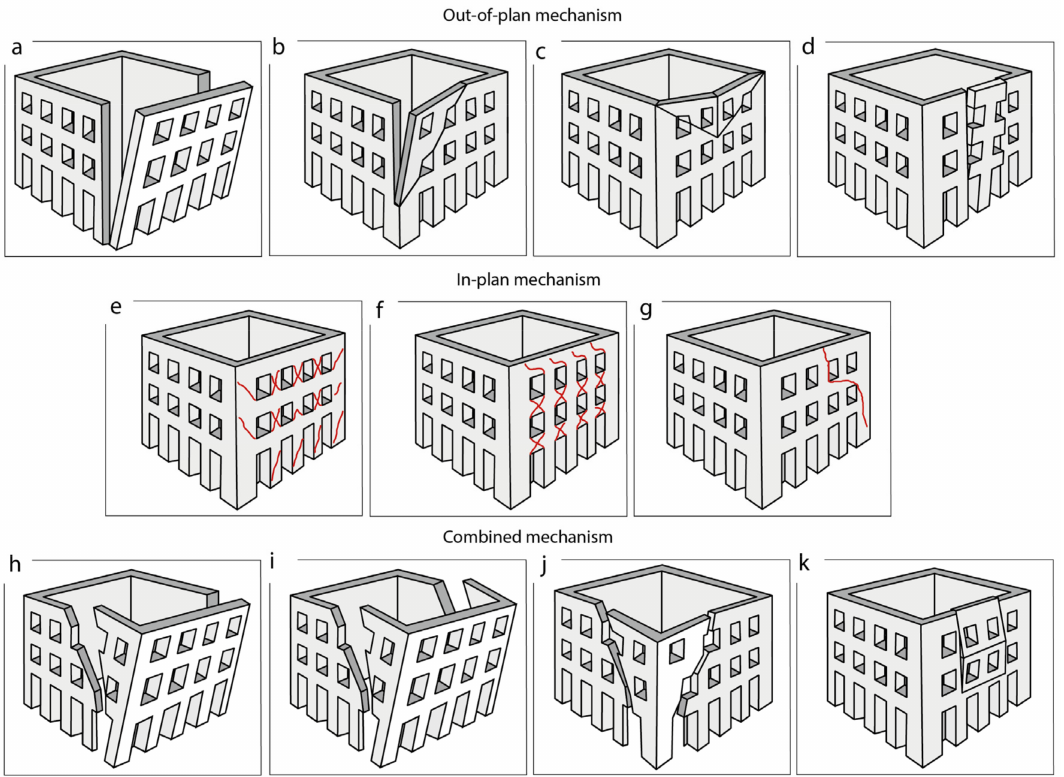
Figure 2. Schematic diagram of possible dissections in relation to a structure affected by a seis- mic event. Out-of-plane mechanisms: ( a ) total simple overturning of the wall; ( b ) partial simple overturning of the wall; ( c ) horizontal wall deflection; ( d ) offset of the wall. In-plane mechanisms: ( e ) bi-directional injuries at jambs; ( f ) bi-directional injuries in correspondence at sills and lintels; ( g ) one-way diagonal injuries. Combined mechanisms: ( h ) partial complex overturning; ( i ) total complex overturning; ( j ) rollover of the corner of the building; ( k ) vertical wall deflection